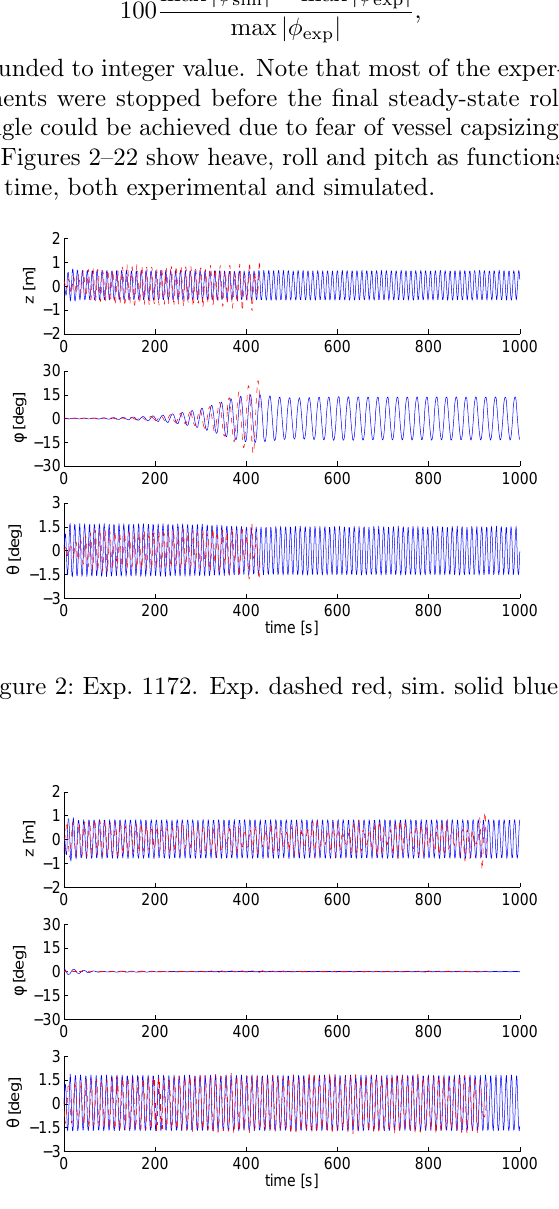
Figure 3: Exp. 1173. Exp. dashed red, sim. solid blue.